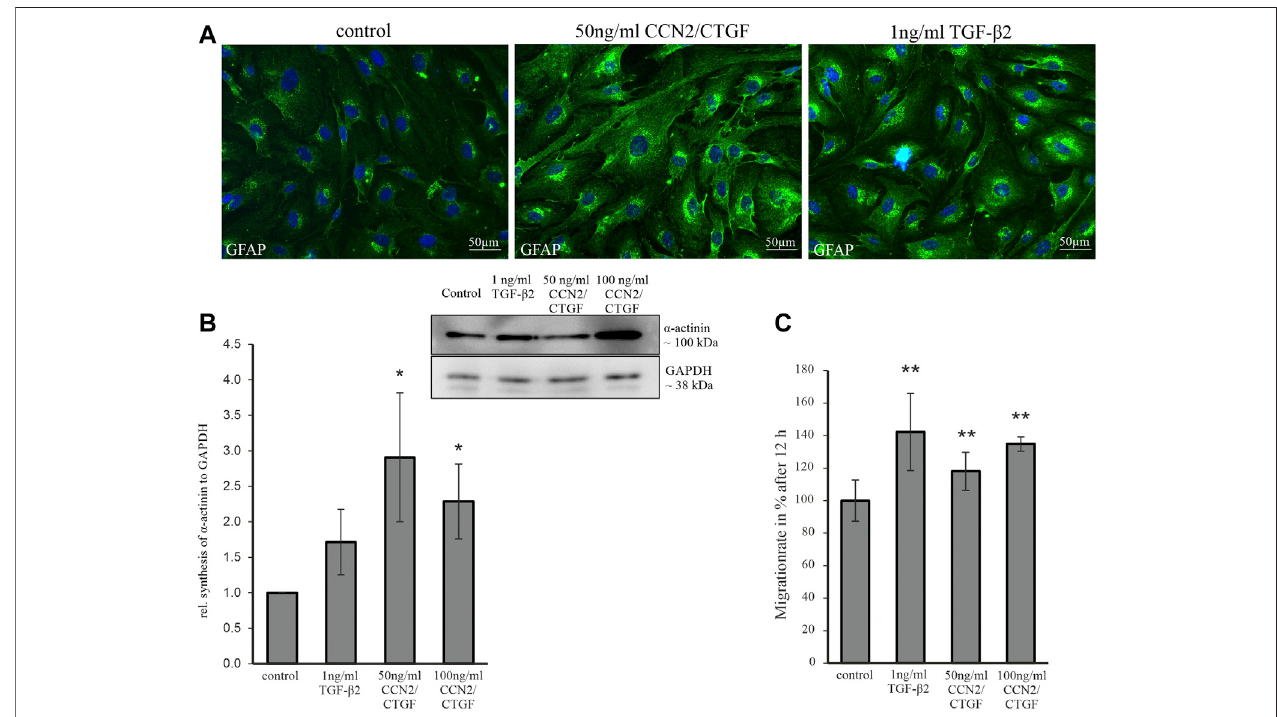
FIGURE 5 | Analysis of astrocyte reactivity, the cytoskeleton and migration rate following treatment with TGF- β 2 and CCN2/CTGF. (A) GFAP immunoreactivity (green) is increased in murine ON astrocytes following TGF- β 2 and CCN2/CTGF treatment. Nuclei are stained with Dapi (blue) (B) Western Blot experiments analyses of α -actininproteinsynthesisinmurineONastrocytes afterthetreatmentwith1 ng/mlTGF- β 2,50 ng/mlCCN2/CTGFand100 ng/mlCCN2/CTGFfor24 h.Densitometric analyses of Western Blot analyses shows the signi fi cant increase in α -actinin protein synthesis. Mean value of untreated cells (control) was set at 1. GAPDH was usedtonormalizeproteinintensity( n =4;50 ngCCN2/CTGF:* p =0.029;100 ngCCN2/CTGF:* p =0.015;unpairedtwo-tailed t -test). (C) Scratchassayanalysesshow asigni fi cantincreasedmigrationrateformurineONastrocytesafterthetreatmentwithng/mlTGF- β 2,50 ng/mlCCN2/CTGFand100 ng/mlCCN2/CTGFfor12 h.Mean valueofmigrationrateofcontrolcellswassetto100%(control:n=15;TGF- β 2: n =12,** p =0.008;50 ng/mlCCN2/CTGF: n =10,* p =0.001;100 ng/mlCCN2/CTGF: n = 4, ** p = 0.0001). Data represented as mean ±